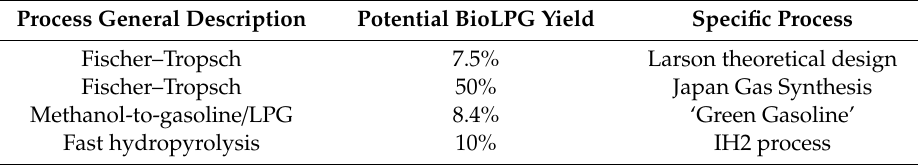
Table 9. Potential (maximum) yield of BioLPG as a fraction of total output by weight.